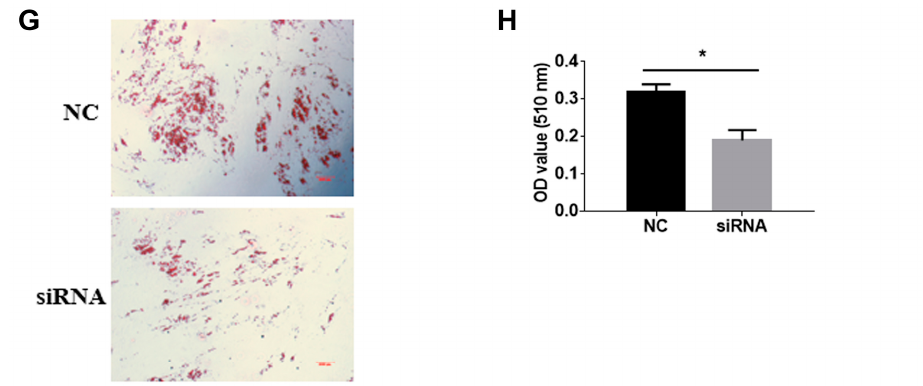
Figure 3. AQP3 silence repressed adipogenic di ff erentiation in porcine intramuscular adipocytes. Cells were transfected with 3 candidate siRNAs targeting AQP3 when reaching 70–80% confluence, and only siRNA-1 could decrease AQP3 transcripts by 70% ( A ) 24 h post-transfection, and it also significantly repressed AQP3 expression 48 h, 4 d, and 8 d post-di ff erentiation ( B ). Expression of adipogenic and lipogenic genes 4 d and 8 d post-di ff erentiation was detected by RT-qPCR, using β -actin as reference gene ( C ). Expression of adipogenesis-related genes 8 d post-di ff erentiation was detected by Western blot ( D ). Western blot images ( E ) and gray analysis statistics ( F ) of PPAR γ , aP2, FASN, and Akt in PIPAs. Lipid accumulation was tested by Oil Red O staining ( G ) and quantified by isopropanol extraction ( H ). n = 3; * p < 0.05, ** p < 0.01.